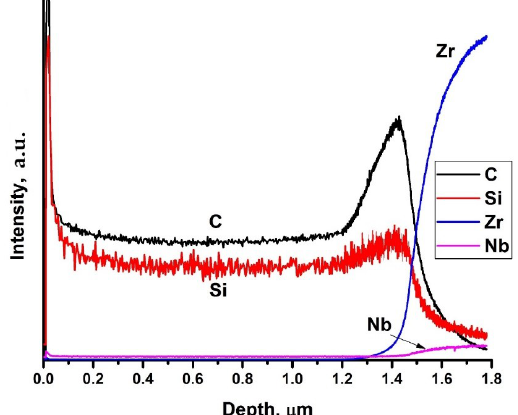
Figure 2. GDOES profiles of elements in SiC-coated Zr–1Nb alloy.